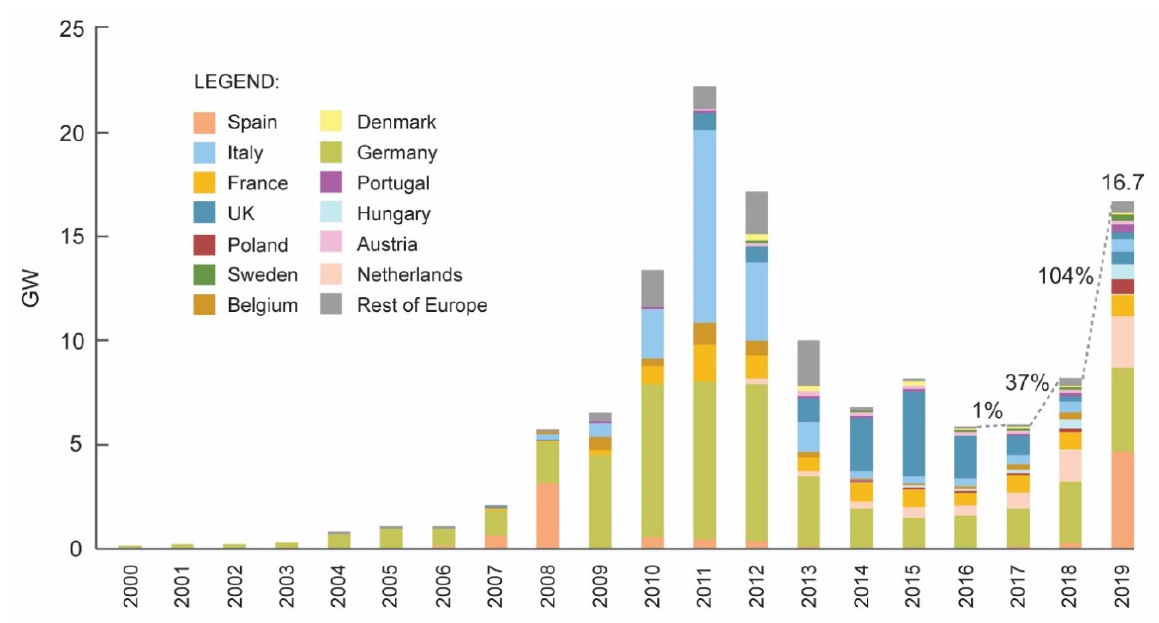
Figure 3. Installed solar power in 2000–2019 with a breakdown by European countries. Source: own study based on [59].